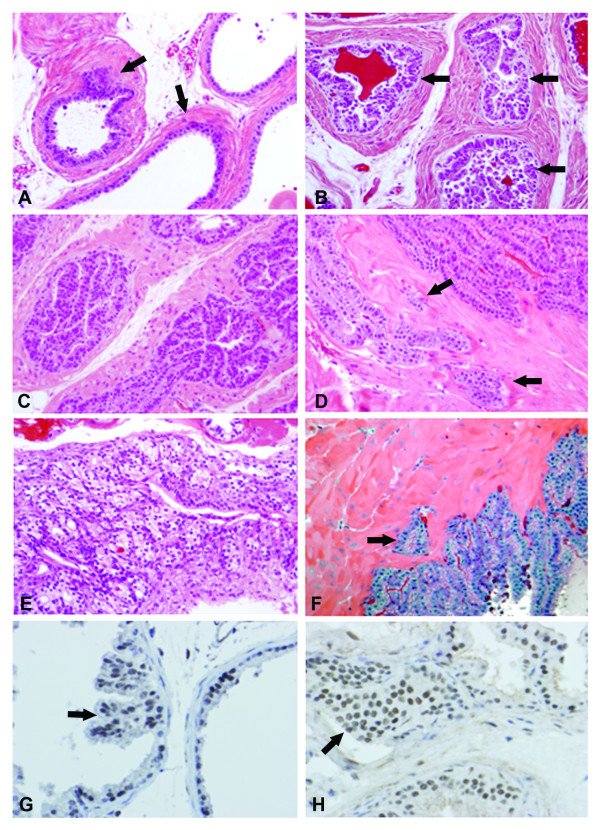
Morphological changes in DLP of p27 deficient mice in the course of carcinogenesis. 1A: Dorso-lateral prostate of 6-month-old p27-/- mice. Note the glandular structures are covered by a single layer of prostate epithelial cells (PEC). Glands are surrounded by a thick layer of myoepithelial cells, stroma cells and collagen (arrows). H&E staining × 200. 1B: High grade PIN in a p27-/- mice treated with MNU and sacrificed at the age of 9 months. Hyperplastic and dysplastic PEC cover entire glands and form papillary and alveolar structures (arrows). The surrounding connective tissue stroma is very abundant (arrow had). H&E × 200. 1C: Ductal carcinoma of papillary type in DLP of a p27-/- animal treated with MNU and sacrificed at the age of 10 months. Note, tumor cells occupy the entire glands lumen. H&E × 200. 1D: Infiltrative prostate carcinoma in a p27-/- animal sacrificed at the age of 12 months. Tumor cells infiltrate the surrounding stroma (arrows). H&E × 200. 1E: Pituitary tumor in a p27-/- mice sacrificed at the age of 10 months. H&E × 200. 1F: Intestinal carcinoma in a p27-/- mice sacrificed at the age of 9 months. Note tumor cell infiltration in the surrounding stroma (arrow). H&E × 200. 1G: RARα expression in DLP of a 6-month-old p27+/- mice. RARα was detected by anti-RARα antibody (SC-251) and ABC kit. The receptor is expressed in papillary structures (arrow) and in the basal layer of epithelial cells. The slide is counterstained by hematoxylin × 200. 1H: RXRα expression in PIN of p27-/- 9-month-old mice. Note that most epithelial cells express RXRα receptor (arrow). The slide is counterstained by hematoxylin × 200.